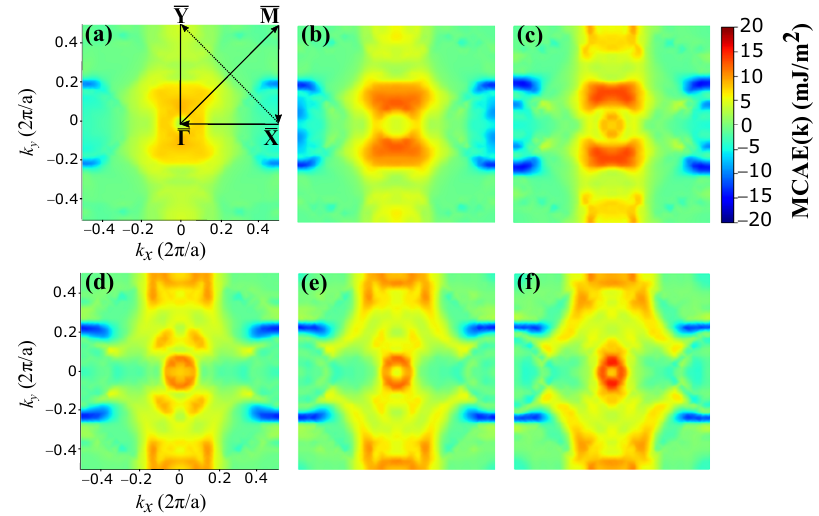
Figure 6. k -resolved MCAE in structure-II for ( a ) η Fe = 3.8%, ( b ) η Fe = 0.3%, ( c ) η Fe = ( d ) η Fe = 5.9%, ( e ) η Fe = 7%, and ( f ) η Fe = − −